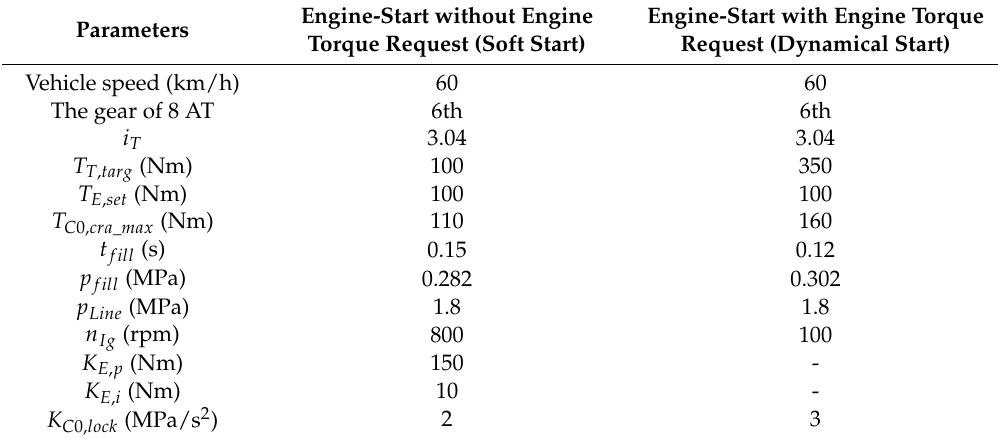
Table 2. Comparative parameters set of